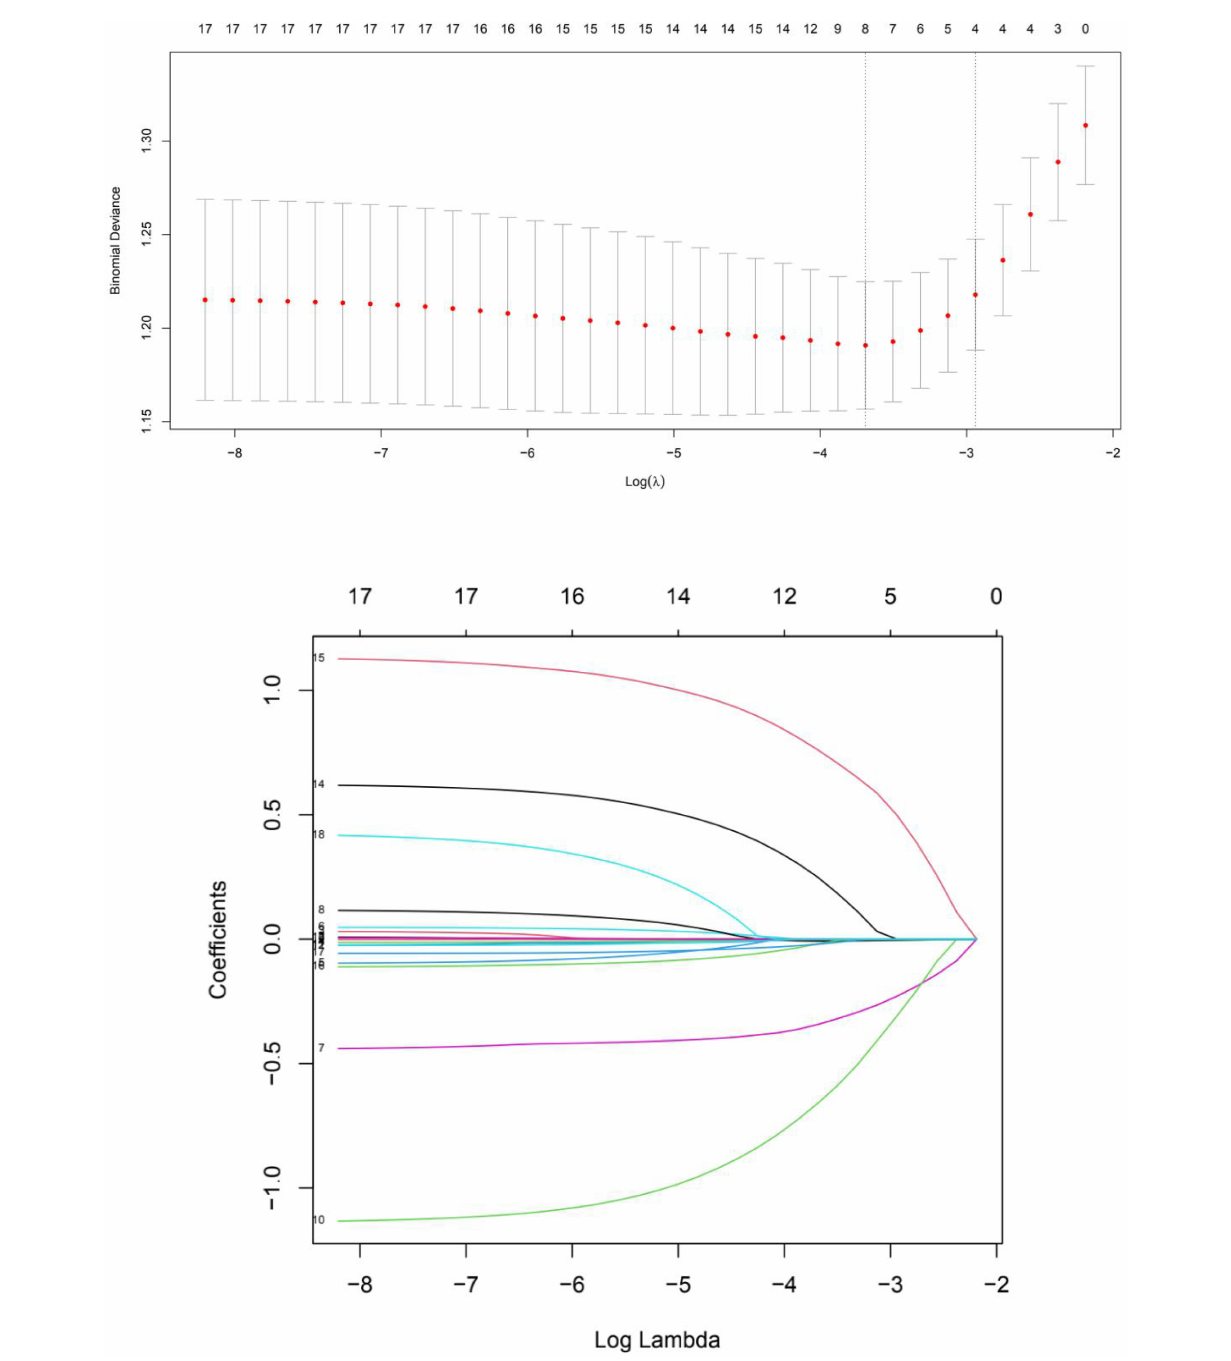
FIGURE1 Cross validation plot for the penalty term and plots for LASSO regression over different values of the penalty